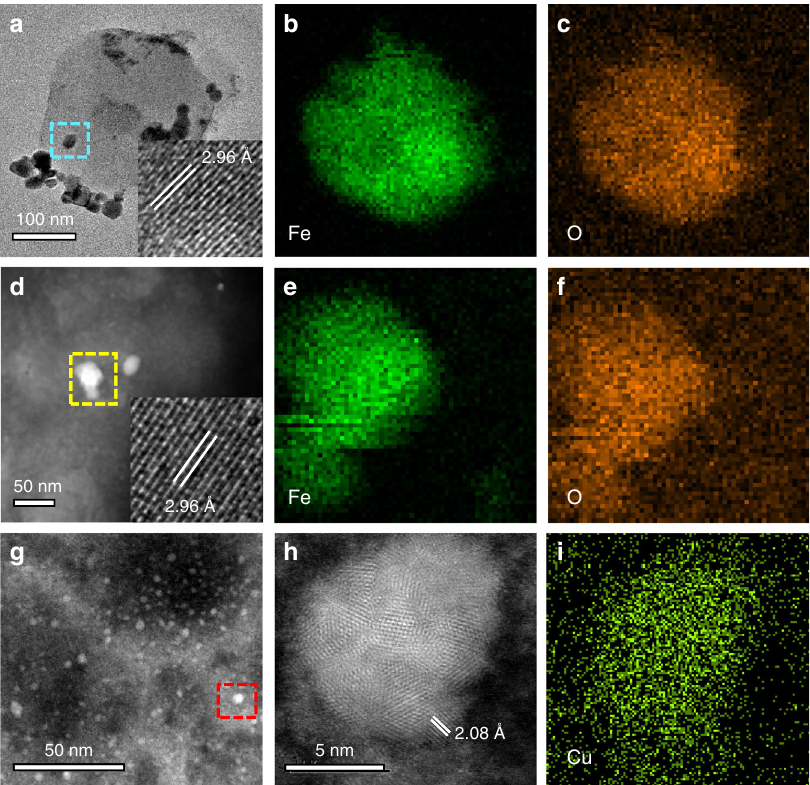
Fig. 3 Structural fi ngerprints of typical NPs extracted from human serum samples. a TEM image of the particles from a healthy human serum sample. The inset shows the high-resolution image of the selected section. b – c EDXS mapping of the particles marked in the cyan square in a . d HAADF-STEM image of the particles from a patient serum sample (S4). e – f EDXS mapping of the particles marked in the yellow square in d . g HAADF-STEM image of the particles from another patient serum sample (S27). h High-resolution HAADF-STEM image and i the corresponding EDXS mapping of the particles marked in the red square in g